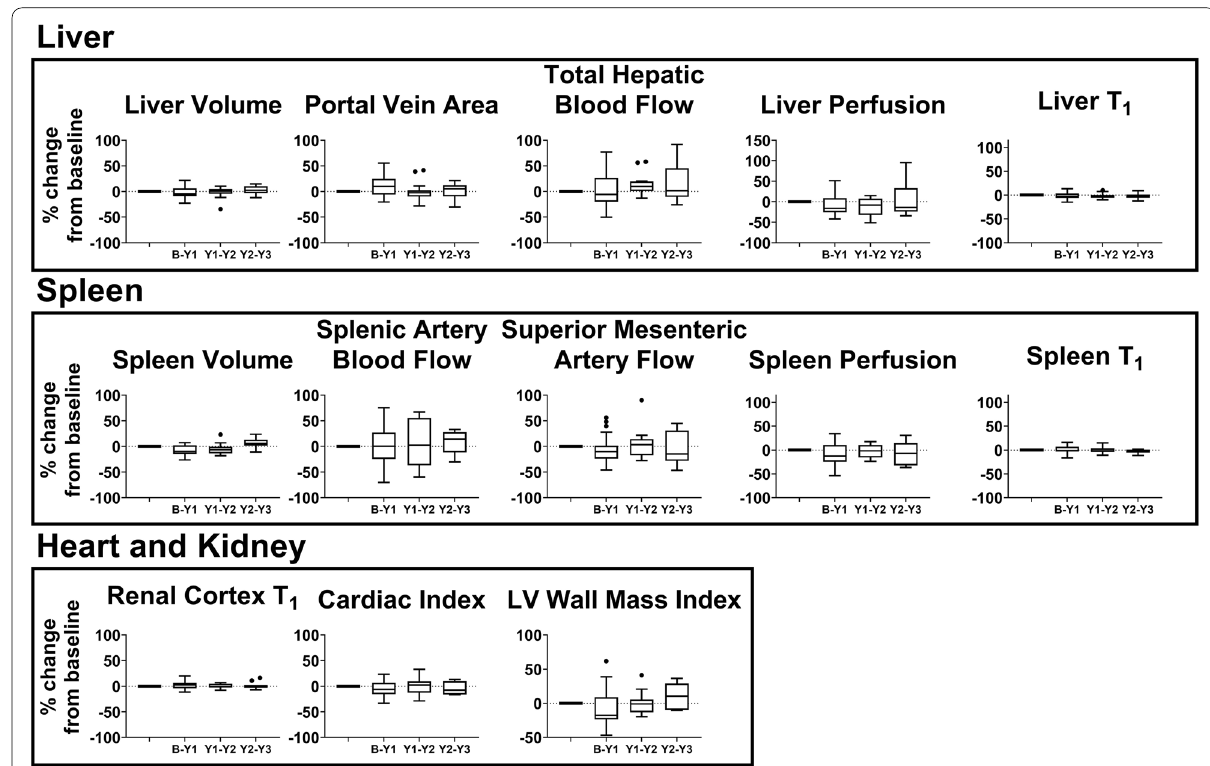
Fig. 4 Year-to-year percentage change in magnetic resonance imaging measures in the stable compensated cirrhosis control group. Measures liver (volume, portal vein area, total hepatic blood flow, liver perfusion, liver T1), spleen (volume, splenic and superior mesenteric artery flow, spleen perfusion, spleen T1), kidney (renal cortex T1), and heart (cardiac index and left ventricle [LV] wall mass index) are shown. Bars indicate interquartile range and horizontal bold line shows the median percentage change, dots represent